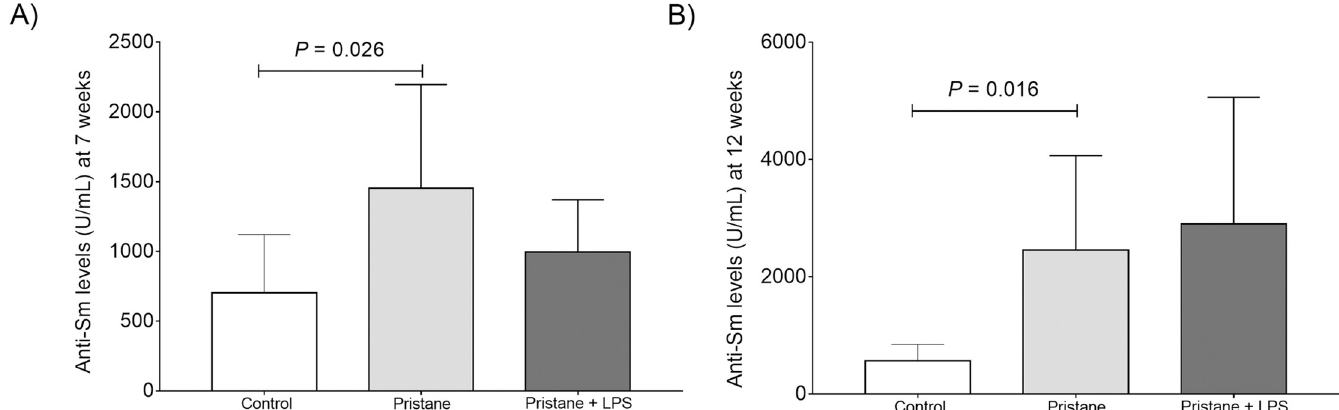
Fig 3. Serum levels of anti-Sm antibodies at 7 and 12 weeks. Data are shown in � x ± SE. Differences between groups unpaired Mann Whitney U test, P < 0.05. A) Anti- Sm antibodies serum levels at 7 weeks. B) Anti-Sm antibodies serum levels at 12 weeks.